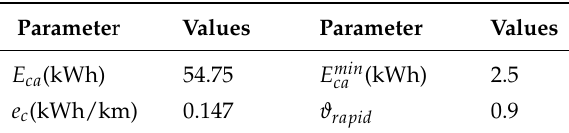
Table 2. Parameters in